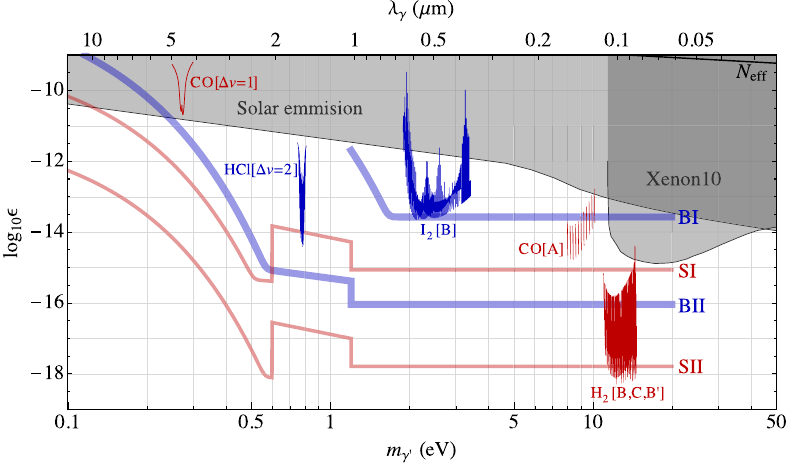
FIG. 8. Reach for the kinetic mixing parameter ϵ of a hidden photon with mass m γ 0 . The SNR ¼ 1 sensitivity estimates for the bulk configurations (BI and BII) are shown as thick blue bands, and those of the stack configurations (SI and SII) as thin red bands. Sensitivity curves are also shown for a single molecular species with the following assumptions: I 2 (blue) in BI, HCl (blue) in BII, CO (red) in SI, and H 2 (red) in SII. Solar emission constraints and DM-induced ionization limits in Xenon10 are shown as gray regions. Above the black line in the top right, hidden photon DM runs afoul of constraints on N eff